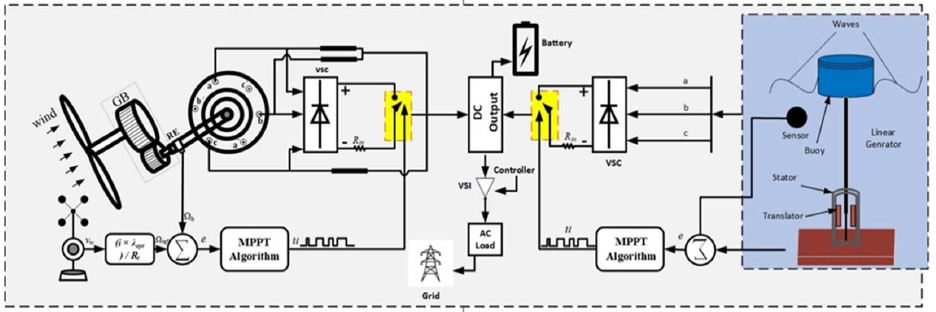
Figure 8. HOWWE with VSC and PLL based VSI .